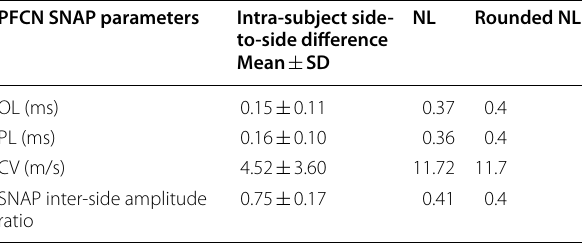
Table 6 Intra-subject side-to-side differences in the posterior femoral cutaneous nerve sensory nerve action potential parameters (46 participants had elicited posterior femoral cutaneous nerve